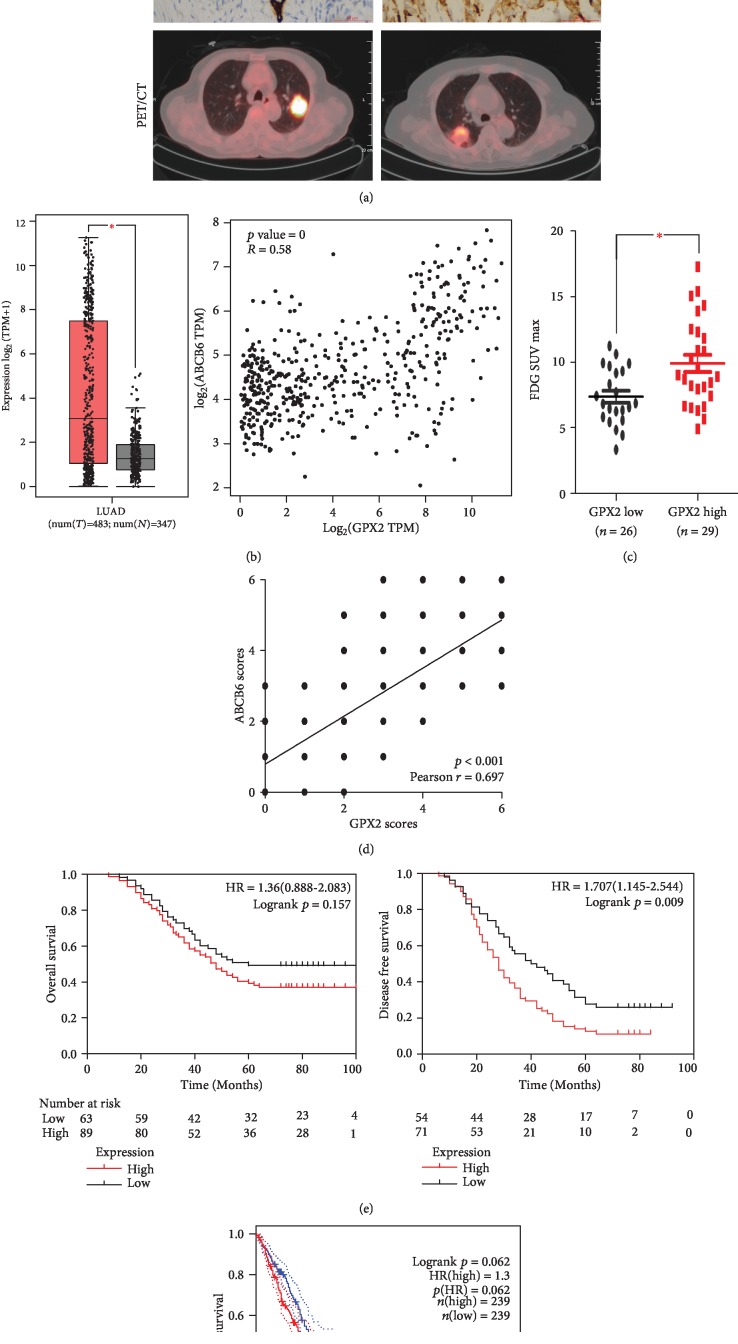
Elevated GPX2 expression predicts poor prognosis. (a) GPX2 and ABCB6 proteins expression by immunohistochemical staining (magnification ×200) in lung adenocarcinoma (LUAD) patients with high and low 18-fluorodeoxyglucose (18F-FDG) uptake. (b) Using the GEPIA online tool, the mRNA expression of GPX2 between LUAD (n = 483) and lung tissues (n = 347) and relationship between GPX2 and ABCB6 mRNA expression in LUAD were analyzed. (c) High expression of GPX2 was correlated with high 18F-FDG uptake in LUAD patients. (d) Relationship between the IHC scores of GPX2 and ABCB6 in our cohort. (e) Univariate survival analysis of overall survival (OS) and disease-free survival (DFS) in our cohort with high expression of GPX2 protein compared with that of low expression. (f) Survival analysis of LUAD from The Cancer Genome Atlas (TCGA) database using the GEPIA tool.